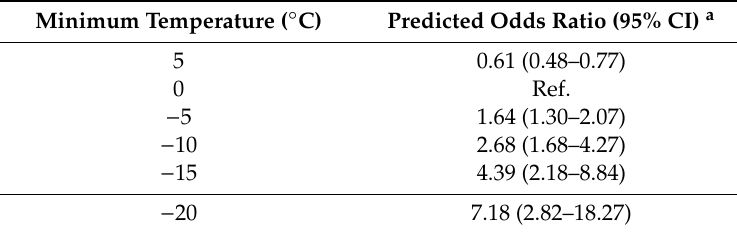
Table 3. Predicted odds ratio estimates of hypothermic injury or death at varying temperatures relative to the reference temperature (0 ◦ C)